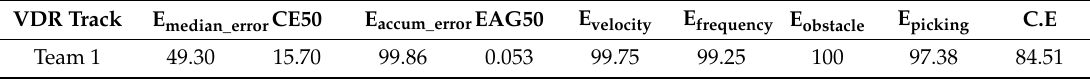
Table 6. Final scores for the evaluation of the xDR Challenge 2018 (VDR track).